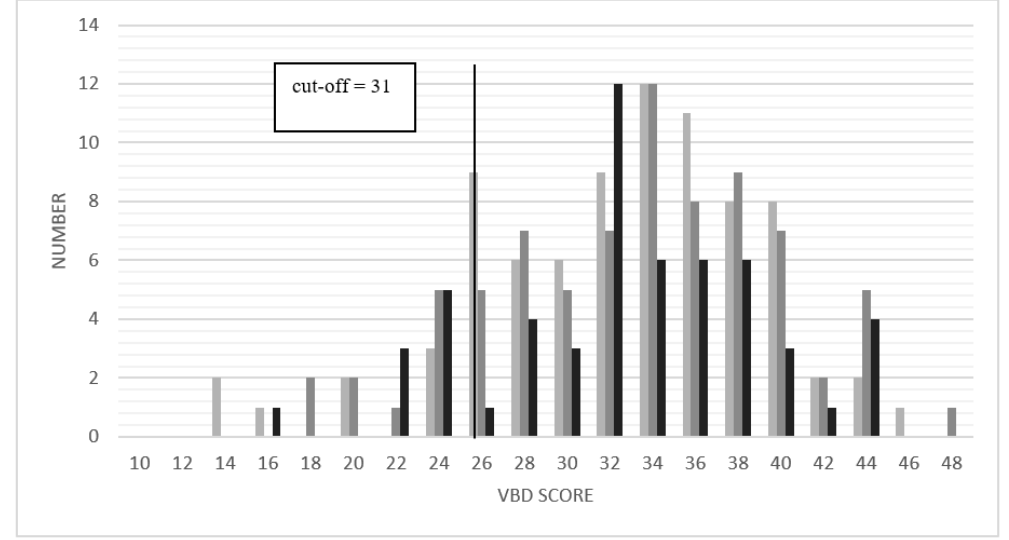
Figure 3. Overview over the VBD scores (FKB-20). notes: black bars represent the VBD score at TP1 ( n = 82), light grey bars at TP2 ( n = 78) and dark grey bars at TP3 ( n = 55).